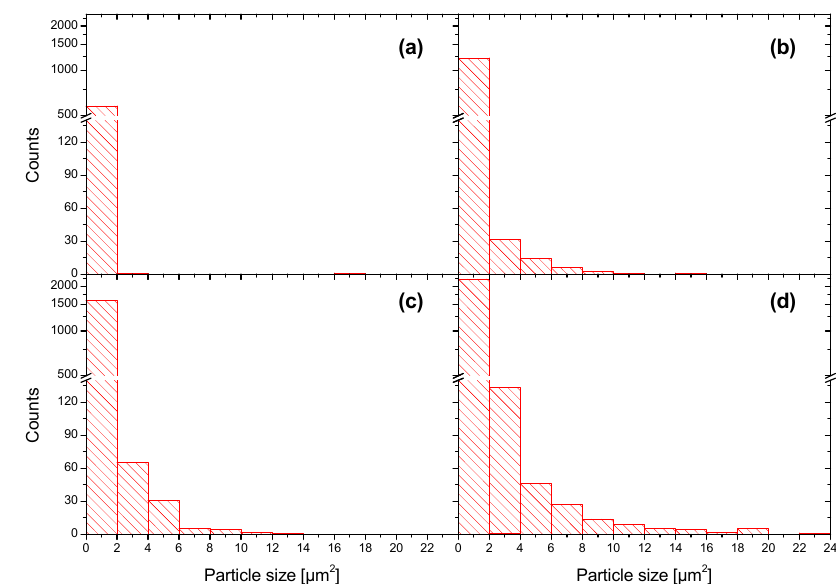
Figure 4. Particle size distribution determined by statistical analysis using the SEM micrographs shown in Figure 1 for Zn-SiO x films grown on Si with secondary precursor flow rates of ( a ) 0, ( b ) 25, ( c ) 50, and ( d ) 100 µl/min.